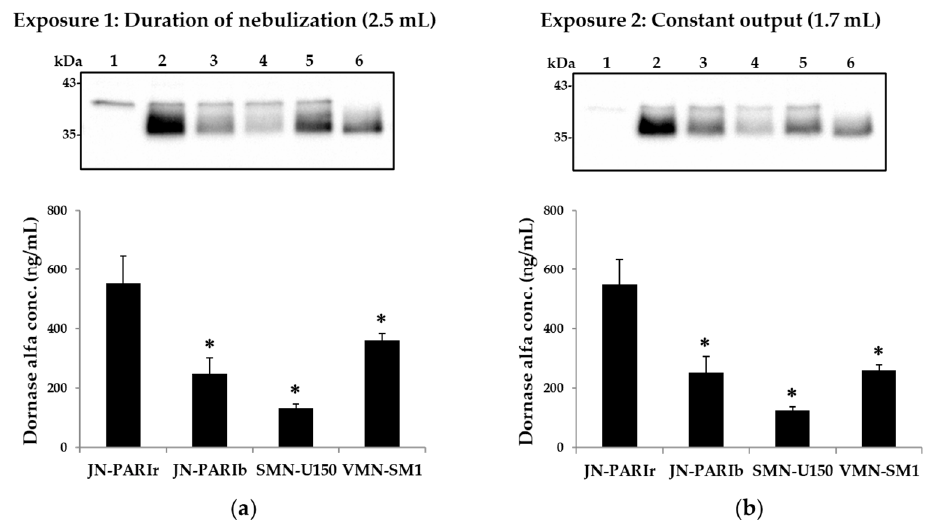
Figure 4. Representative Western blot images and levels of dornase alfa in bronchoalveolar lavage fluid (BALF) from mice treated using the four nebulizers. ( a ) Duration of nebulization with 2.5 mL of dornase alfa (Exposure 1); ( b ) Constant output at 1.7 mL (Exposure 2). Normal mice BALF ( lane 1 ), JN-PARIr-treated mice ( lane 2 ), JN-PARIb-treated mice ( lane 3 ), SMN-U150-treated mice ( lane 4 ), and VMN-SM1-treated mice ( lane 5 ). Lane 6 shows the blot obtained for 10 ng of dornase alfa ( lane 6 ). All values are means ± SD. * p < 0.05 versus JN-PARIr.